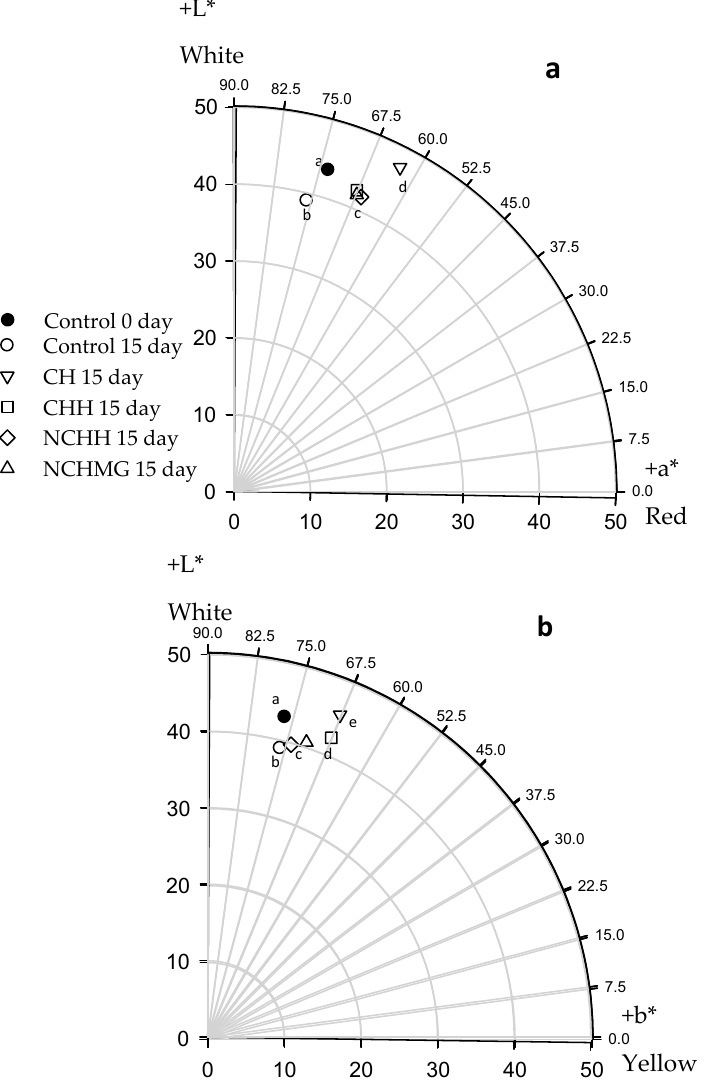
Figure 3. Color measurements on the epicarp of pitayas: ( a ) 0 day and ( b ) 15 days of storage at 10 ◦ C and relative humidity (RH) of 80% (See Table 2 for treatment identification). Data are the mean ( n = 27). Different letters among treatments mean significant differences ( p < 0.05).